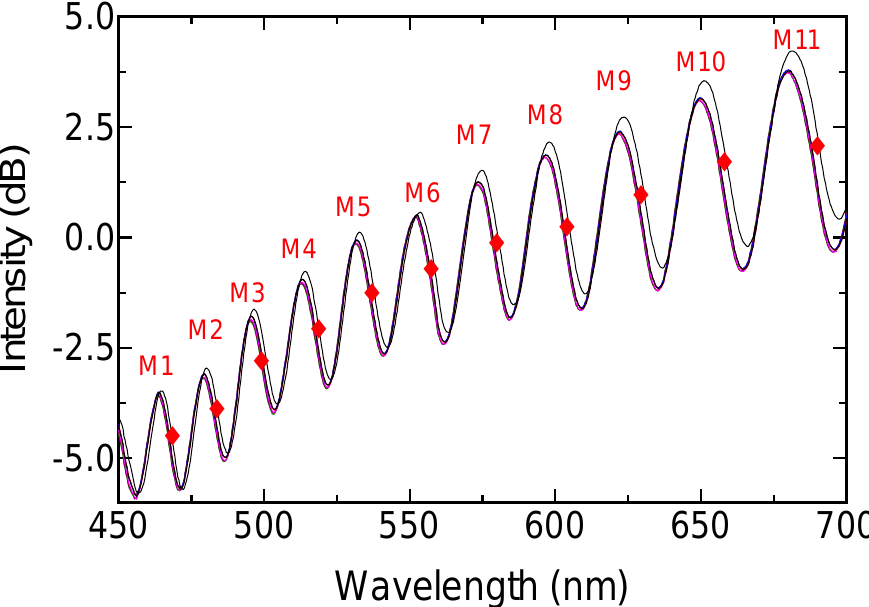
Figure 7. Middle regions of the visible interferogram. Table 2. Second-order regression adjustment of the middle region through visible interferogram.